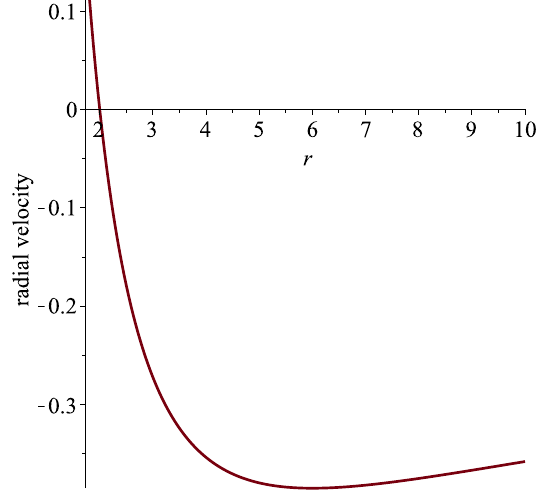
Figure 1. Behaviour of ˙ r in the Schwarzschild geometry when using Schwarzschild curvature coordinates for m = 1 and (cid:101) = 1. Note the curve crosses the r axis only at r = 2, and the coordinate velocity is negative all the way from the horizon to spatial infinity.